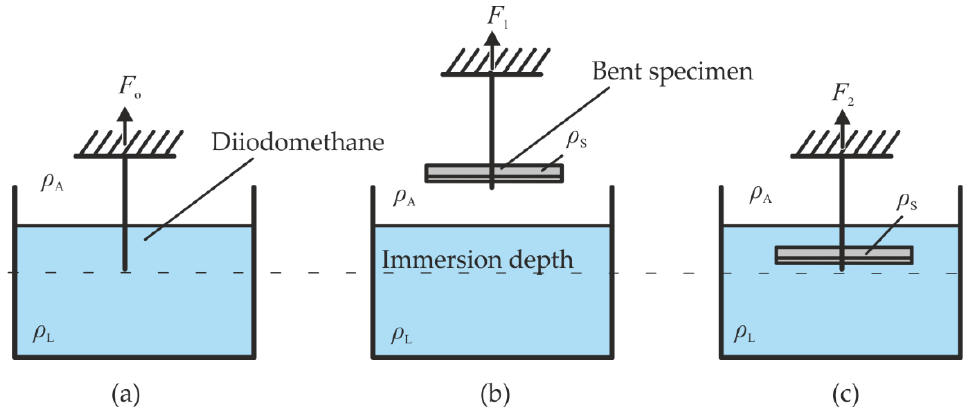
Figure 6. Buoyancy principle for density measurement: ( a ) calibration of the suspension in ambient air; ( b ) weighing of the specimen in ambient air; ( c ) weighing of the specimen in the measuring liquid.